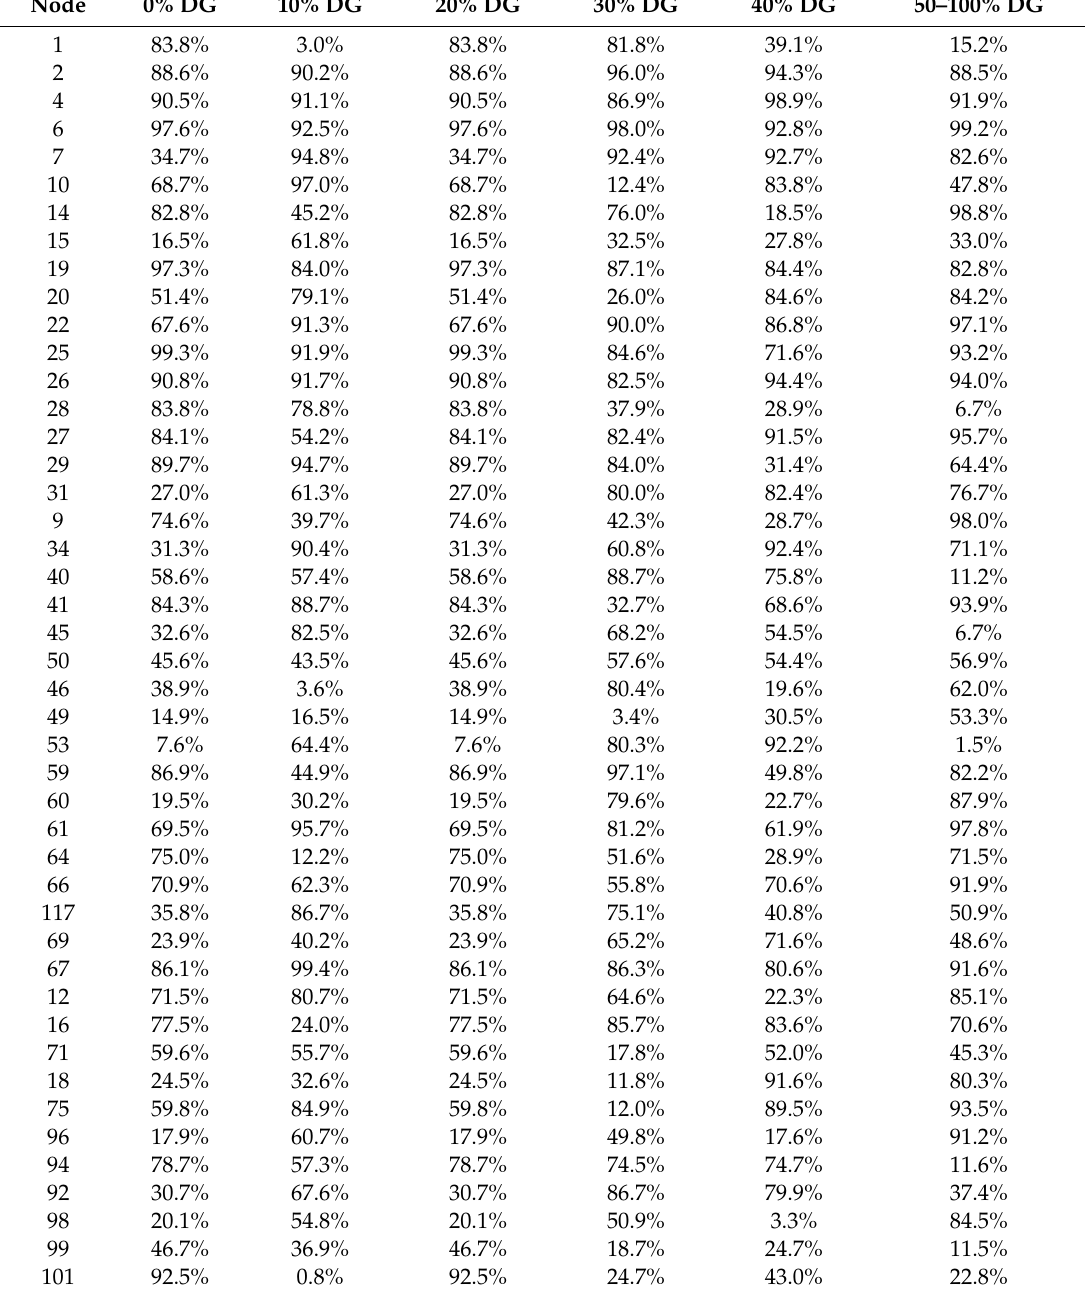
Table 6. Loading per node for case